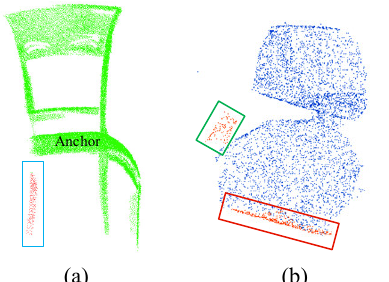
Figure 4. The unclassified cases: (a) missing parts in the chair leg (blue box), (b) the anchor over-segmentation (red box) and chair’s tiny parts (green